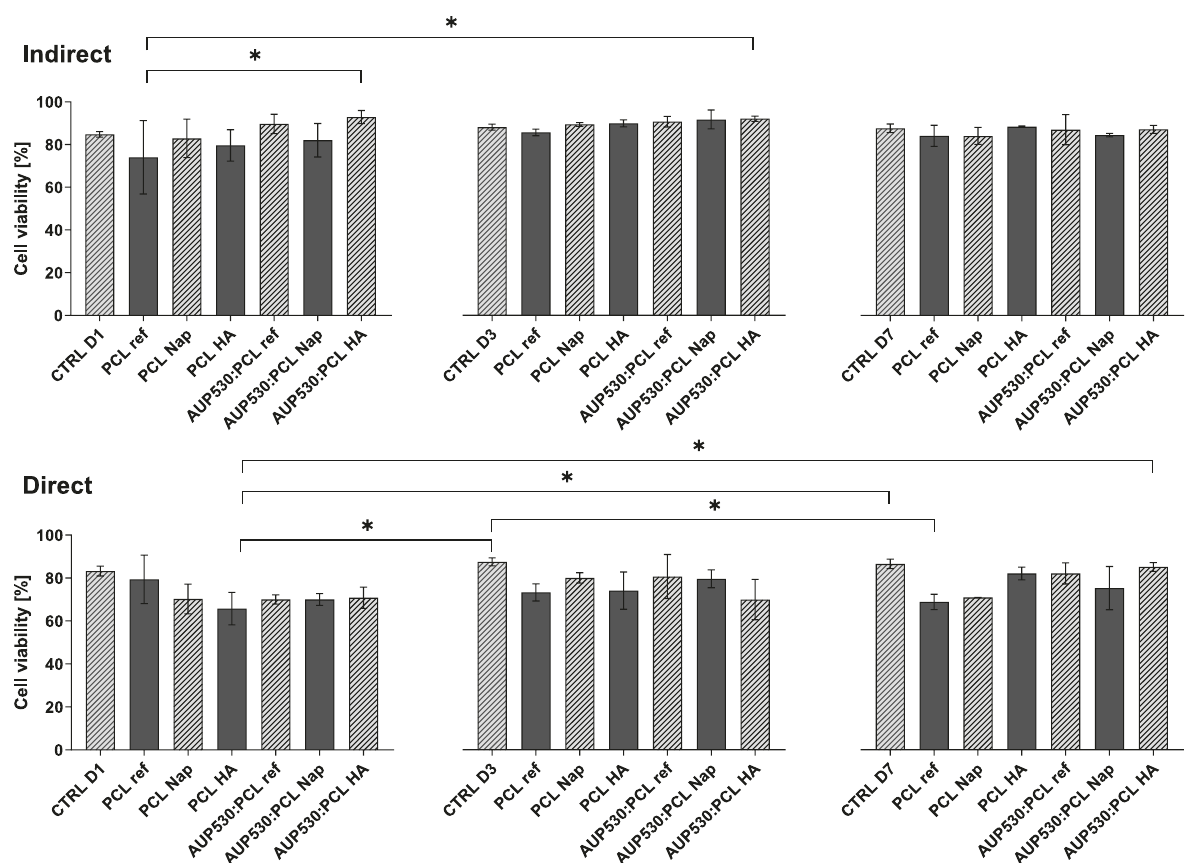
Fig. 7 Cell viability of indirect (top) and direct (bottom) assay using hFBs, by a Ca-AM/PI staining at day 1, 3 and 7. (* p < 0.05). Tissue culture plastic was used as a positive